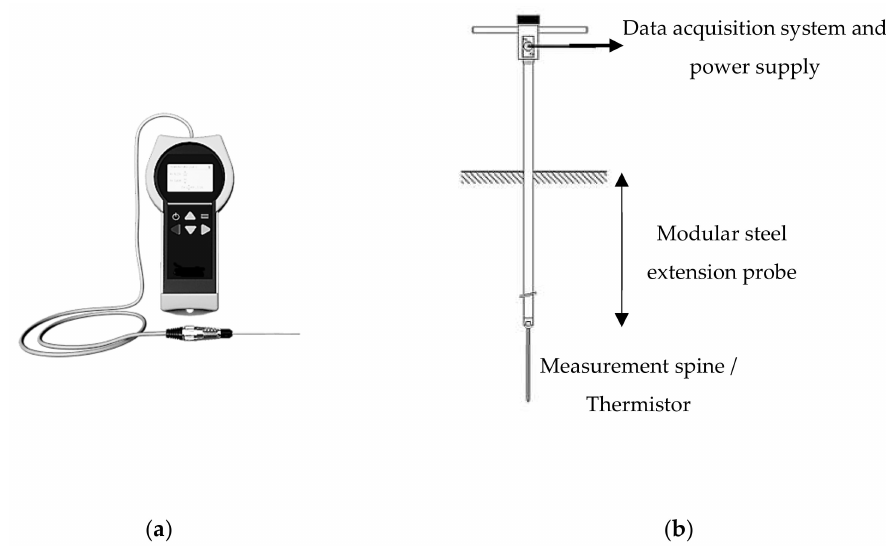
Figure 7. Thermal probes for thermal conductivity measurements: ( a ) laboratory version and ( b ) in situ version with an extension